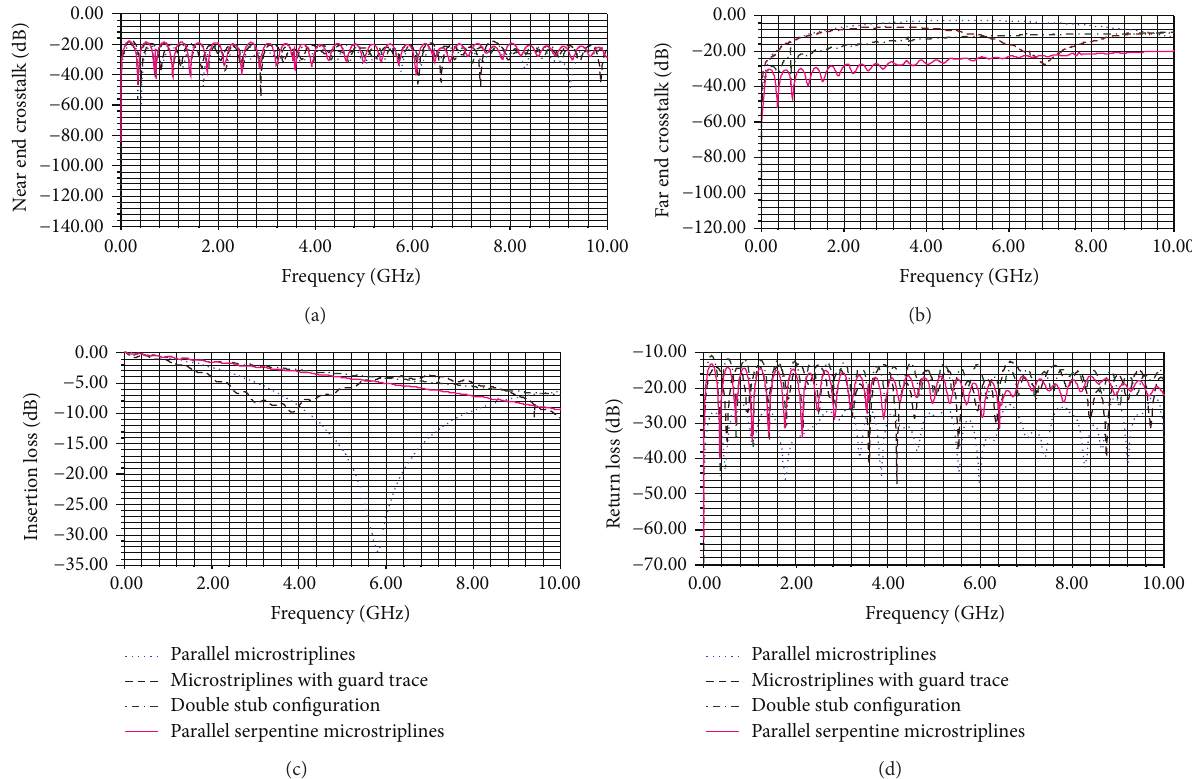
Figure 7: Simulation results for various microstripline structures for the (a) NEXT and (b) FEXT. (c) Insertion loss; (d) return loss.